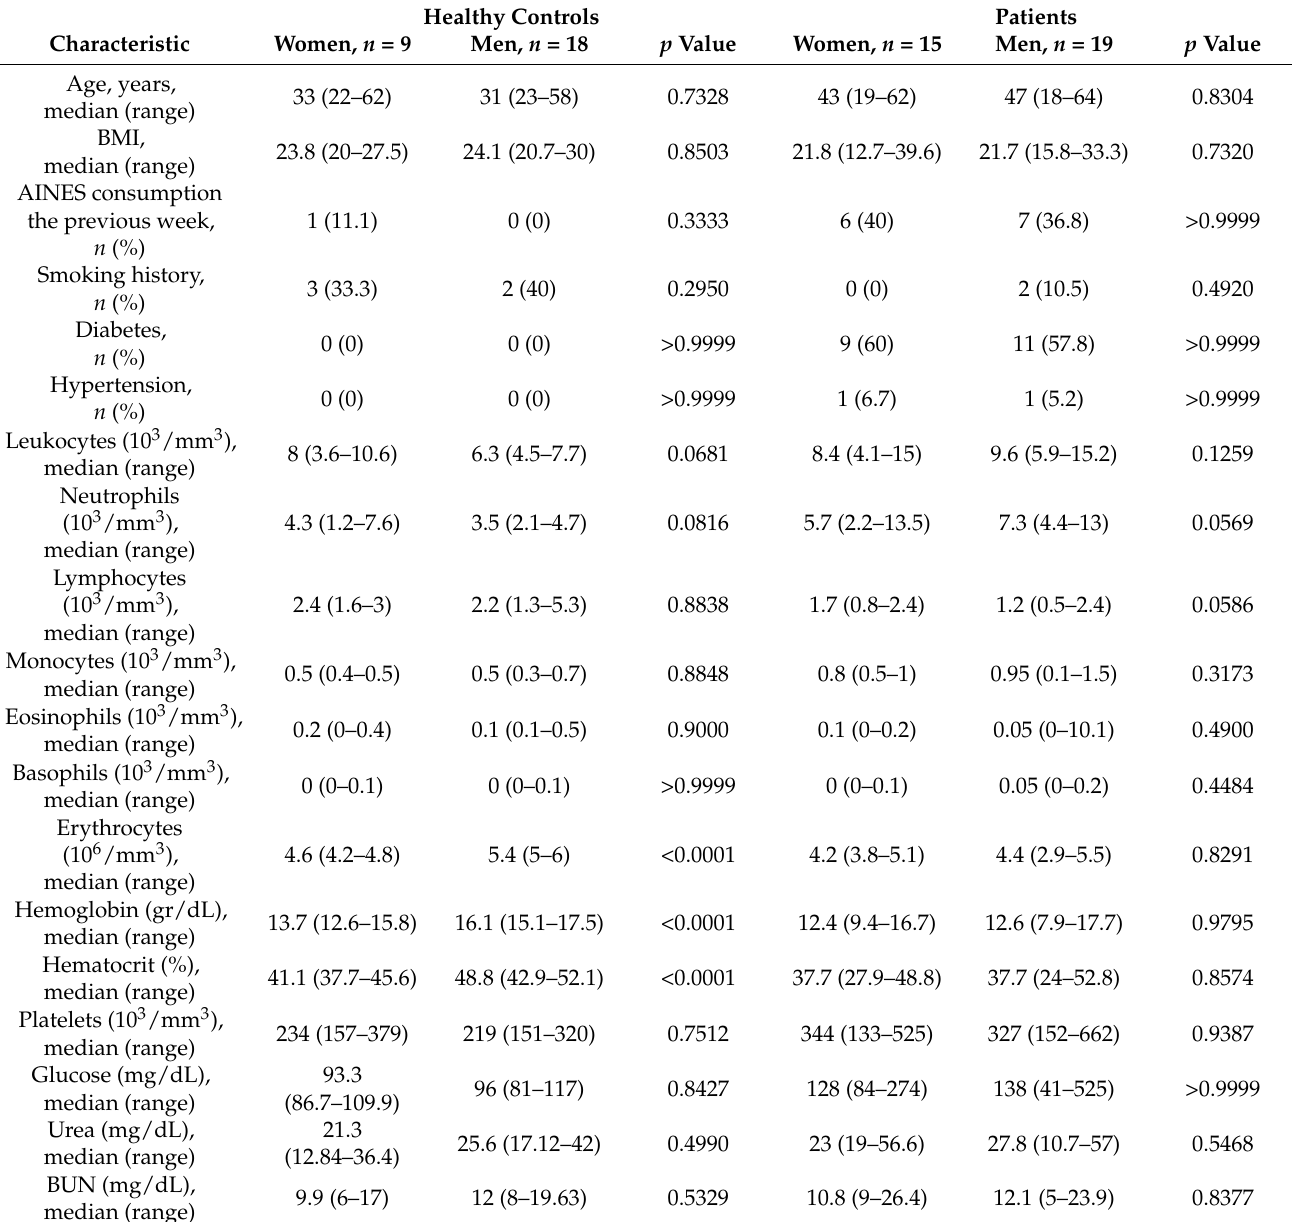
Table 1. Demographic and clinical characteristics of the